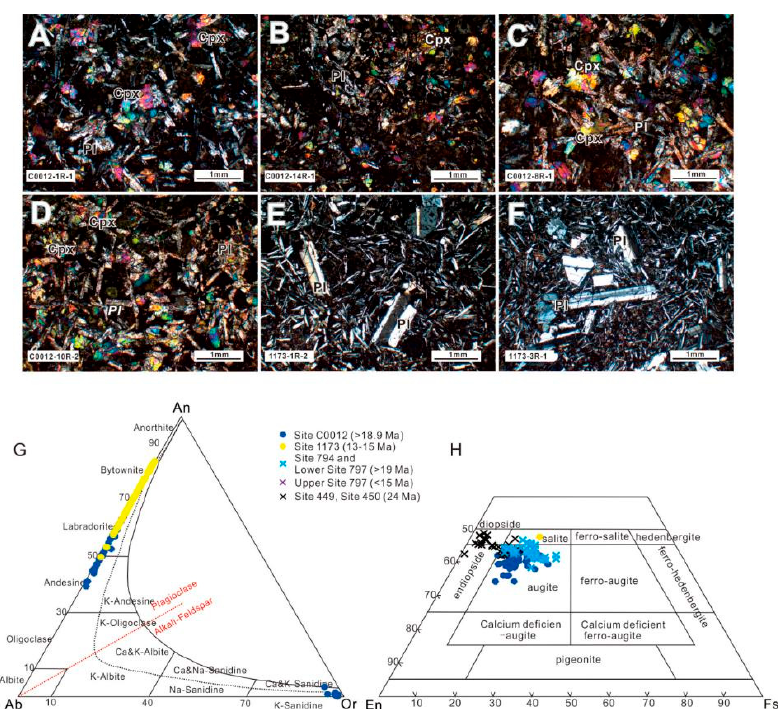
Figure 4. Microphotos of the Site C0012 and Site 1173 volcanic rocks from the Shikoku Basin. ( A , B ) Phenocrysts of clinopyroxene and plagioclase in C0012-1R-1 and C0012-14R-1 basalts; ( C , D ) porphyritic texture with phenocrysts of clinopyroxene, plagioclase, and K-feldspar in C0012-8R-1 and C0012-10R-2 basalts; ( E , F ) porphyritic texture with phenocrysts of plagioclases in tholeiitic basalts (1173-1R-2, 1173-3R-1); Ol, olivine; Cpx, clinopyroxene; Pl, plagioclase. Plots of the Feldspar classification ( G ) and Pyroxene classification ( H ) for the Site C0012 and 1173 volcanic rocks from Shikoku Basin. The data from Parece Vela Basin are cited from Reference [51]; the data from Japan Sea are cited from Reference [27]. Figure 4G is modified from Reference [49]; Figure 4H is modified from Reference [50].